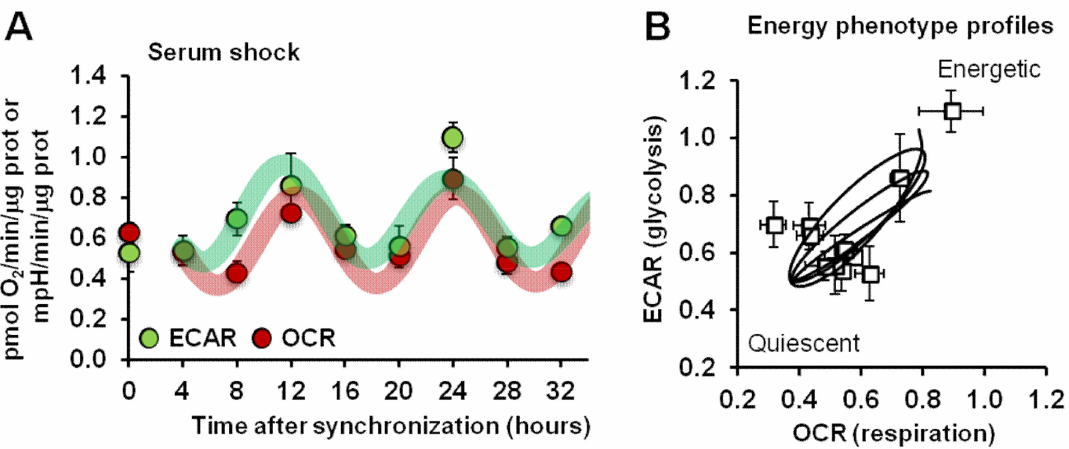
Figure 1. Analysis of mitochondrial respiration and glycolysis in serum shocked synchronized normal human dermal fibroblast (NHDF) cells. ( A ) The oxygen consumption rate (OCR) and extracellular acidification rate (ECAR) were assessed by a Seahorse Analyzer in intact NHDFs every four hours post-synchronization for 32 h under resting conditions. Data are expressed as pmol O 2 / min / µ g protein for OCR and mpH / min / µ g protein for ECAR. See Materials and Methods for experimental details. ( B ) Energy map obtained plotting the ECAR and OCR values obtained in ( A